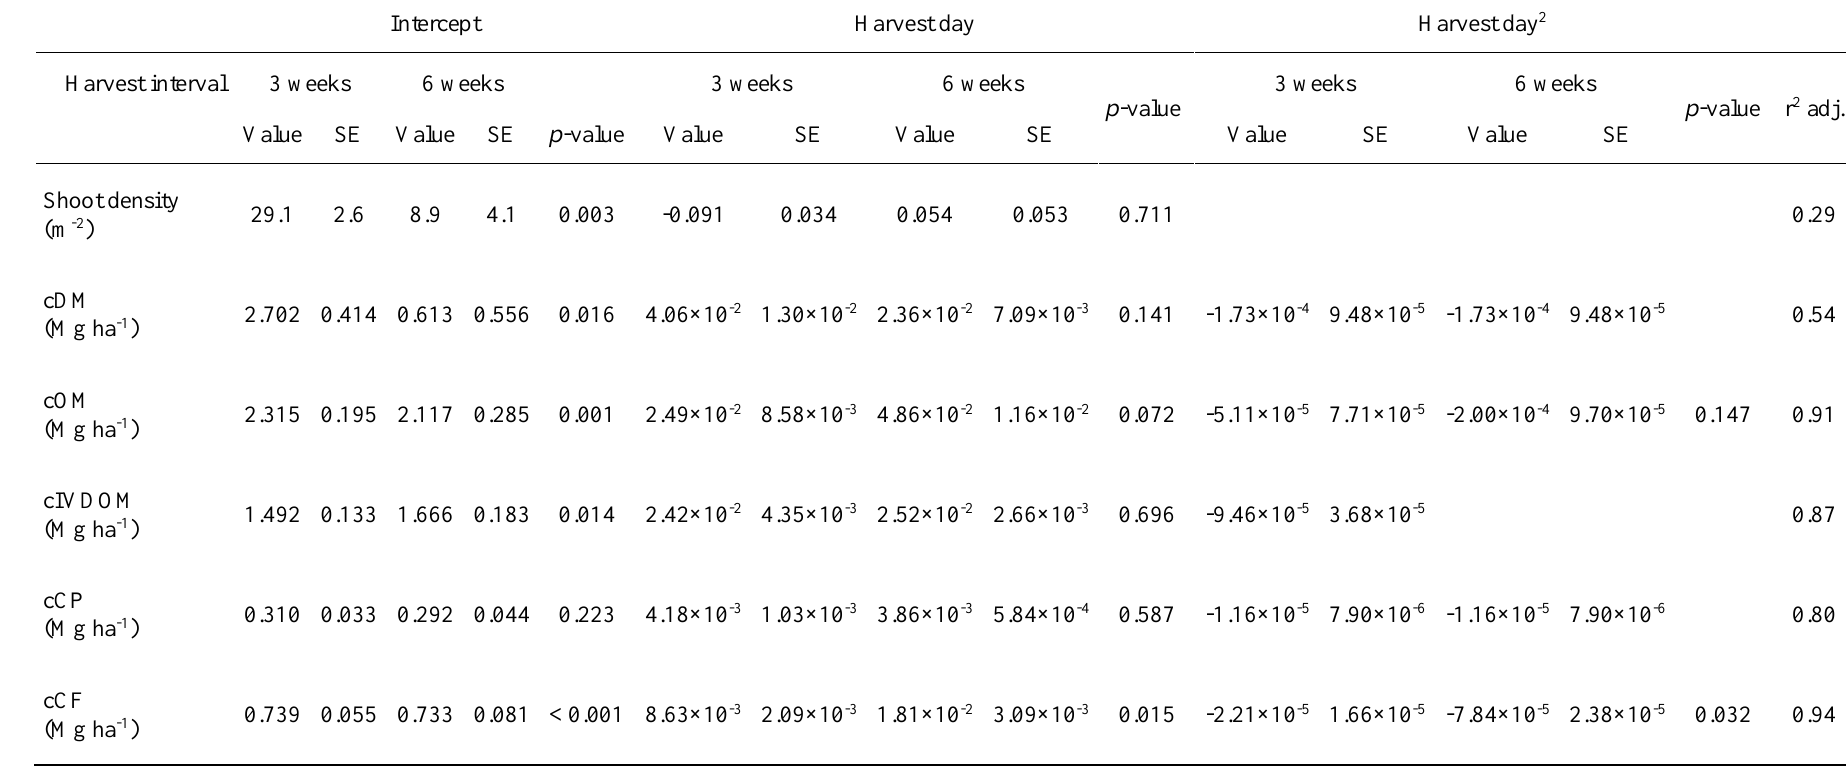
Table 5. Experiment III: Effect of harvesting frequency (3-weekly or 6-weekly) on shoot density and cumulative (c) dry matter (DM), organic matter (OM), in vitro digestible organic matter (IVDOM), crude protein (CP) and crude fibre (CF) yields of T. latifolia biomass contents one year after planting. Fitted parameters to